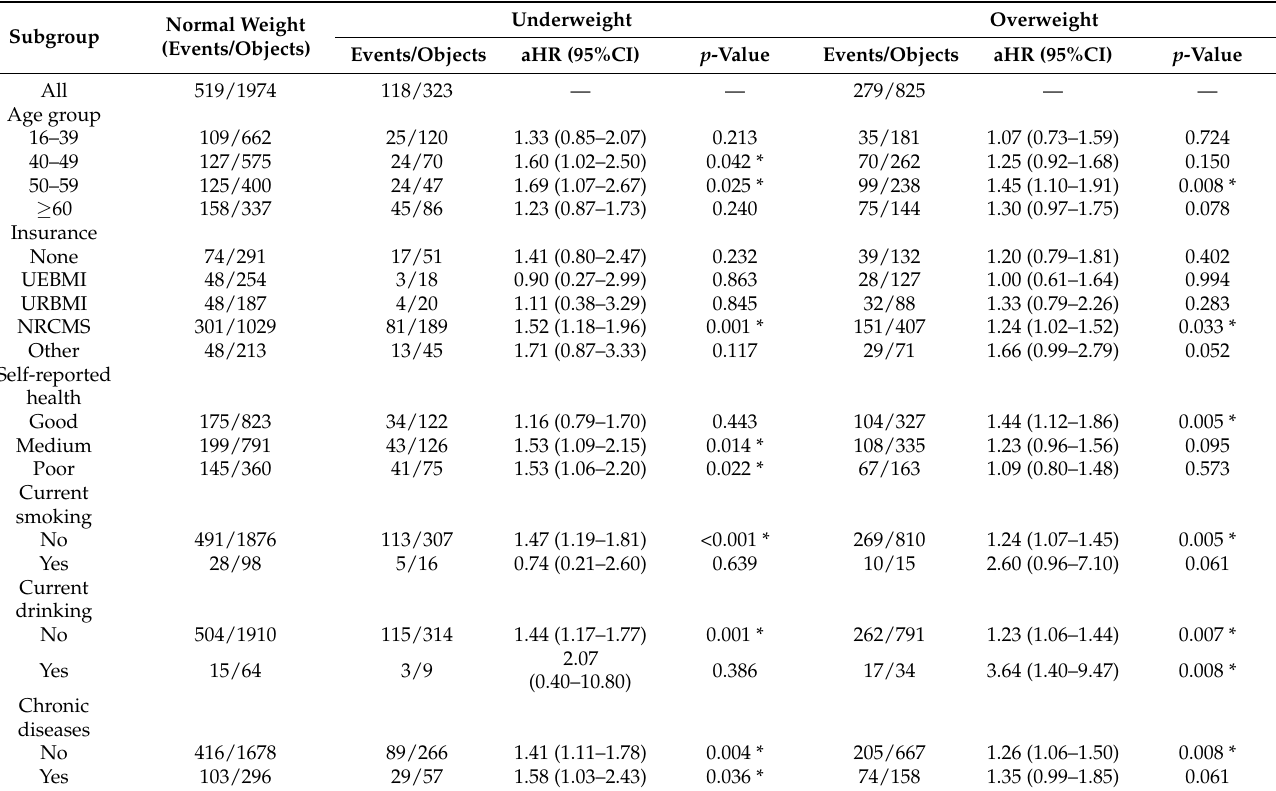
Table 3. Subgroup analyses for association of underweight and overweight with risk of CHE in female